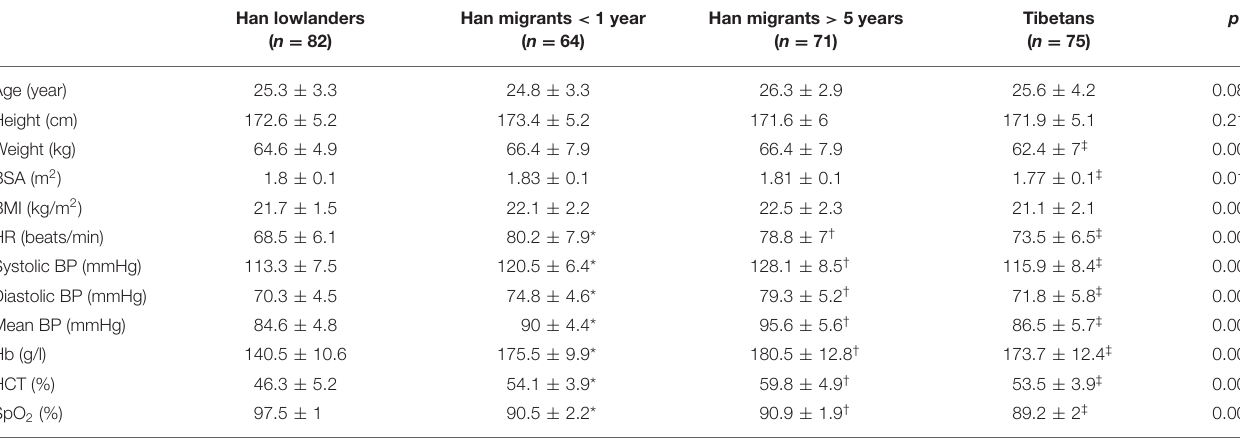
TABLE 1 | Clinic characteristics in Han lowlanders, Han migrants and native Tibetans. Han lowlanders ( n =